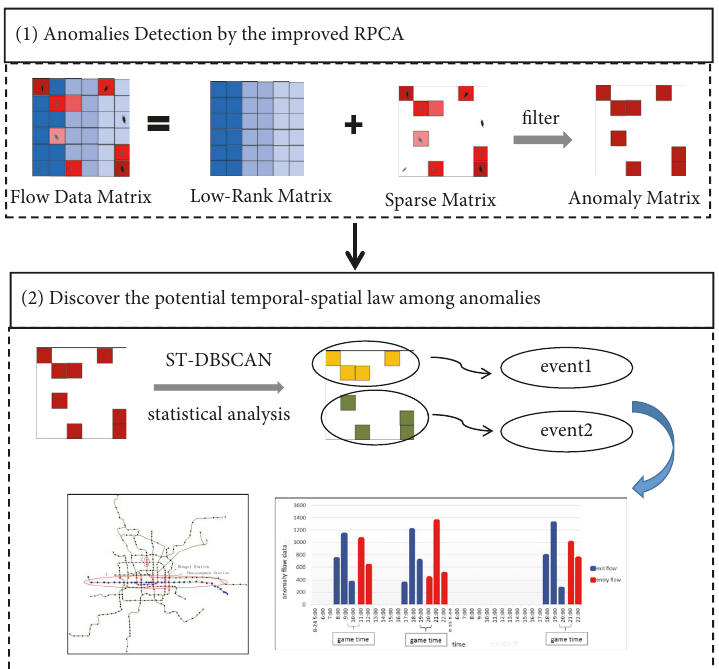
Figure 1: The whole procedure of anomalies detection by the improved RPCA. (1) Decompose the matrix of subway passenger flow into a low-rank matrix and a sparse matrix, filter the sparse matrix decomposed by the improved RPCA, and then acquire the anomaly matrix. (2) Mine the potential laws and discover the possible relations among anomalies through ST-DBSCAN algorithm and statistical